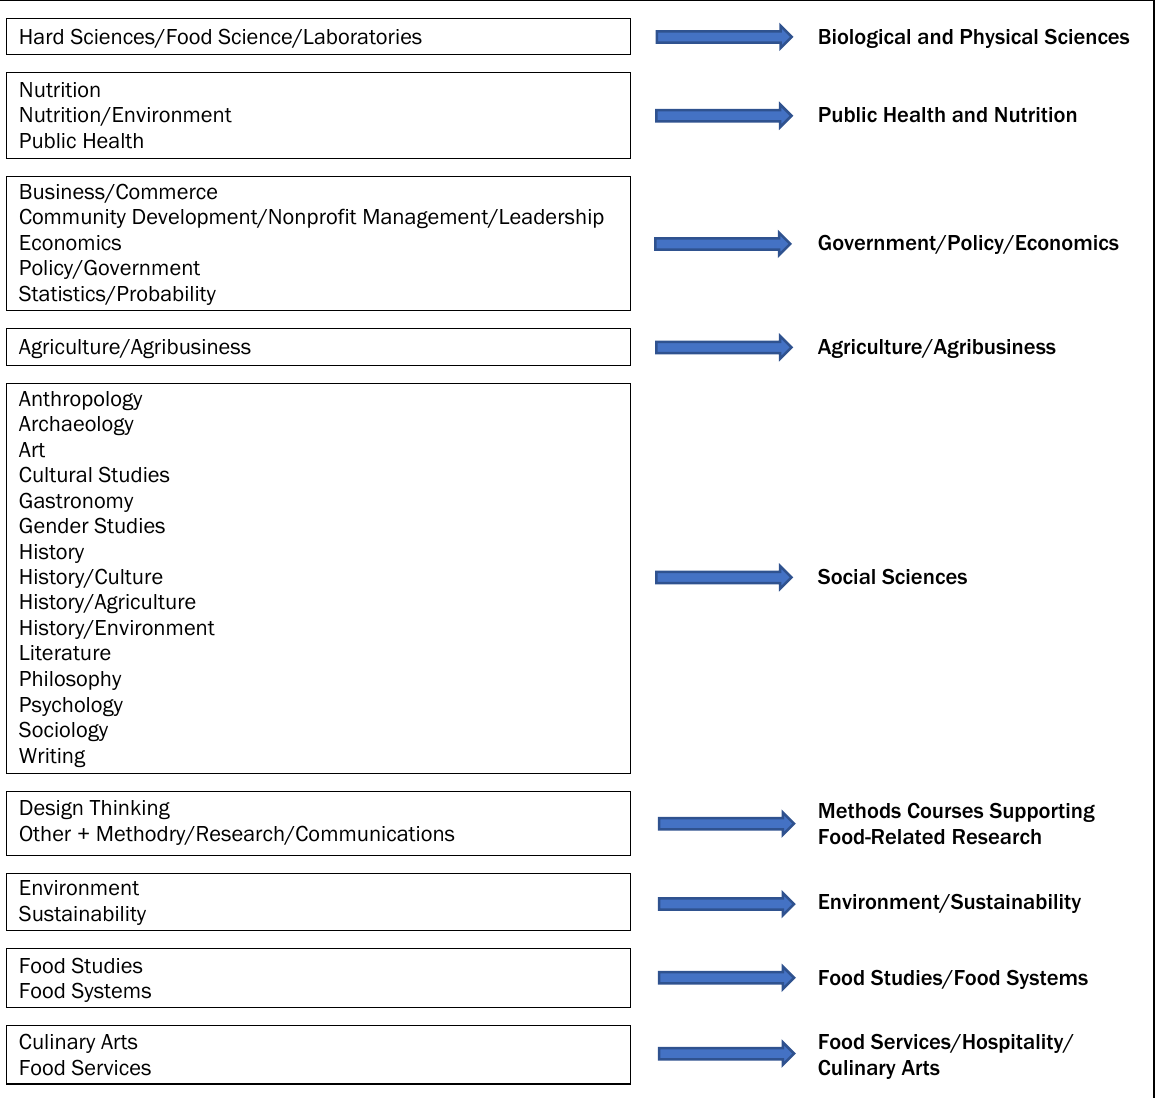
Figure 1. Categorization Process for Interdisciplinary Food-Related